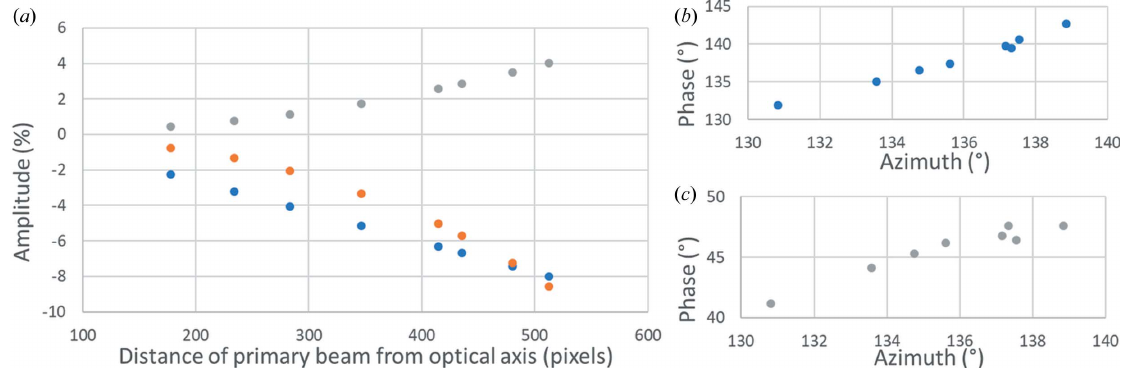
Figure 6 ( a ) The amplitudes of the magnification correction (orange), parabolic (blue) and elliptical (grey) distortions as a function of distance between the primary beam and the optical axis. ( b ) and ( c ) The dependence of the phases of ( b ) the parabolic (blue) and ( c ) the elliptical (grey) distortions on the azimuth of the difference vector of the primary beam from the optical